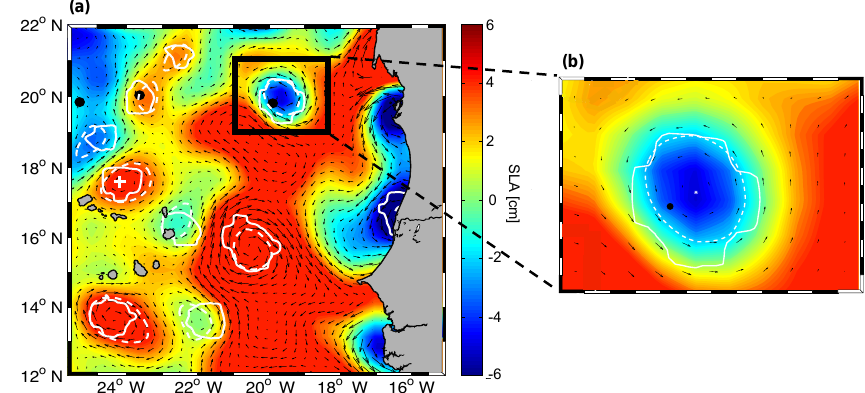
Figure 4. Snapshot of the SLA for 22 December 2010, with the results of the eddy-detection methods: OW method (solid white line) and the GEO method (dashed white line) with geostrophic velocities superimposed (black arrows). The black dots mark Argo float profiles, the white cross in (a) indicates the CVOO mooring. In (b) a zoom of a selected region with a cyclonic eddy is